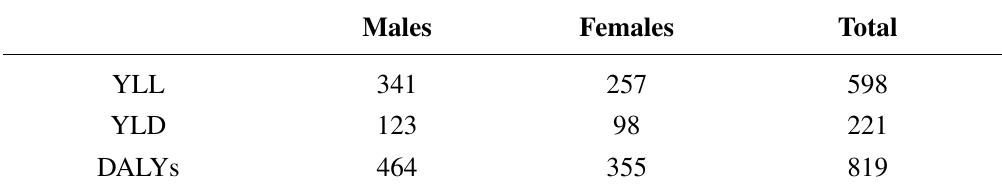
Table 2. Estimate of potentially avertable number of years of life lost (YLL), years lived with disability (YLD) and disability-adjusted life years (DALYs) (at 0% discount rate, 0% age weight) in the 2011 Dutch population cohort aged ě 20 years, if reducing sodium in soups by